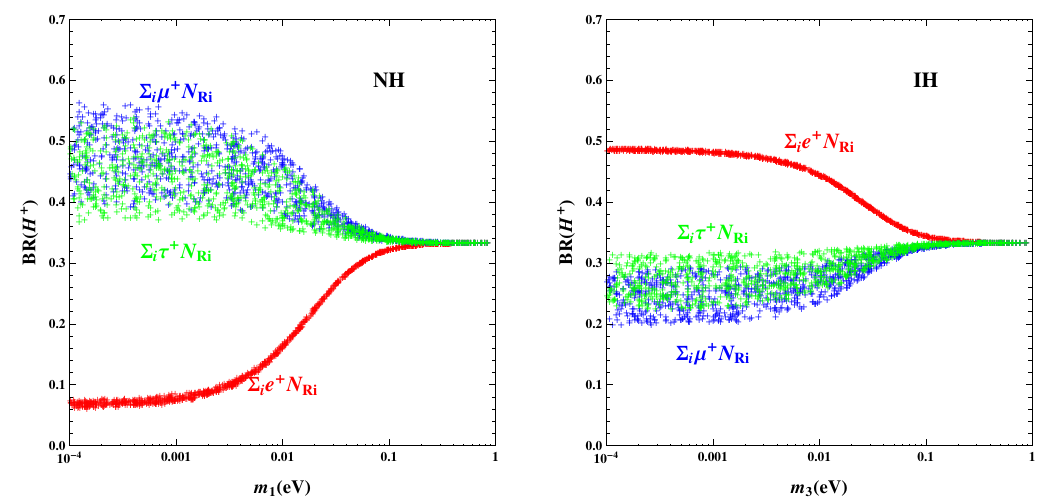
Figure 2 . Branching ratios of the charged scalar H + as a function of the lightest neutrino mass for normal (left panel) and inverted (right) hierarchy.